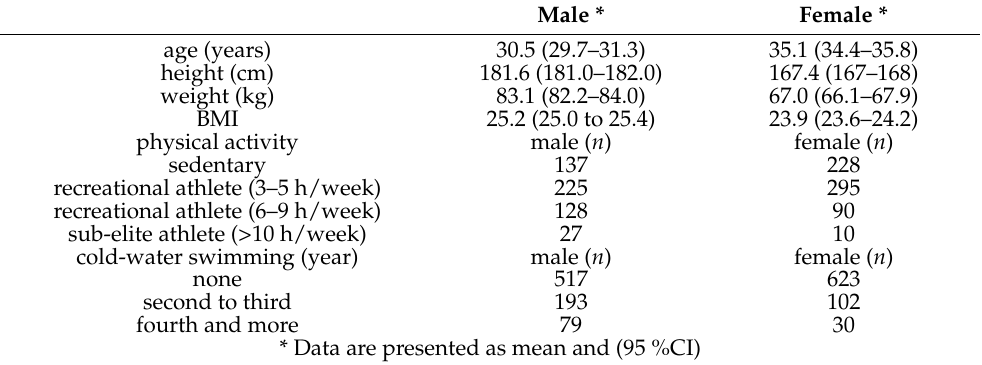
Table 1. Physical and lifestyle characteristics of the cohort of analyzed individuals